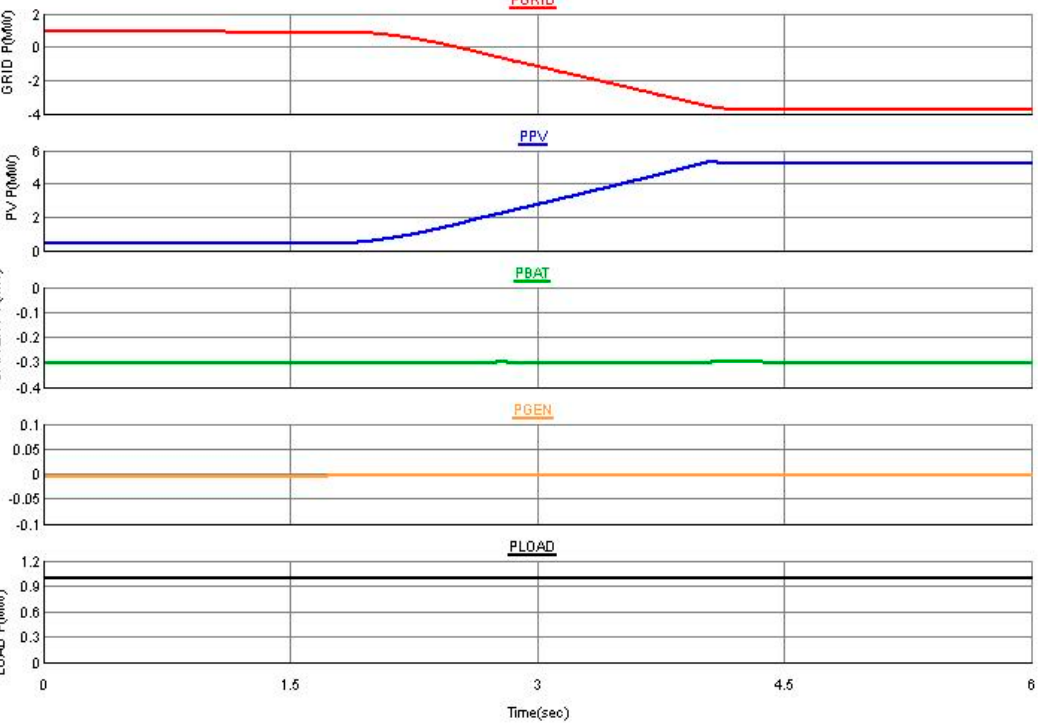
Figure 14. Grid power P GRID , PV array output power P PV and load power P LOAD.